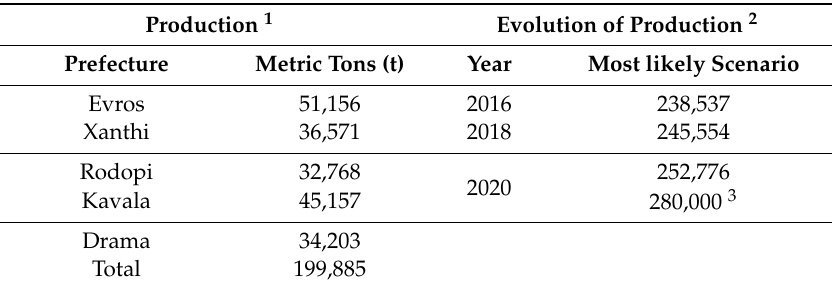
Table 3. MSW Production, projection and composition* in Eastern Macedonia and Thrace Region (data for 2015) (data compiled and derived from